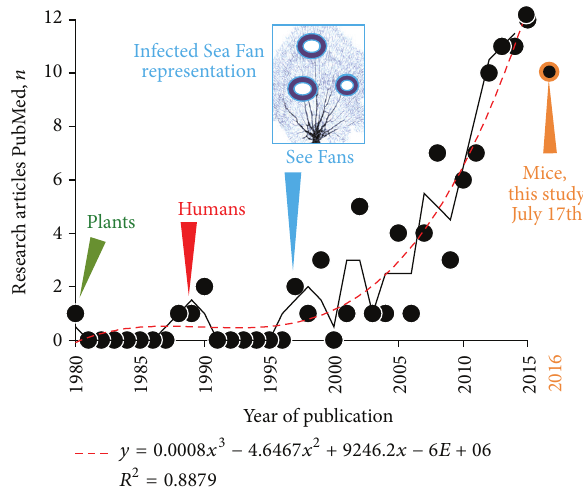
Figure 1: The frequency of peer-review studies on Aspergillus sydowii has increased exponentially over the last decade, with the curve shoulder starting after the fungus was linked to emerging epidemic infections in Caribbean corals. The first report was in plants in Egypt, 1980 [9]. Systematic scoping review of articles in PubMed until February 2016. Two-step moving average (solid line) and polynomial estimation curve (dashed line; 𝑦 = 𝑛 of publications estimate; 𝑥 ,